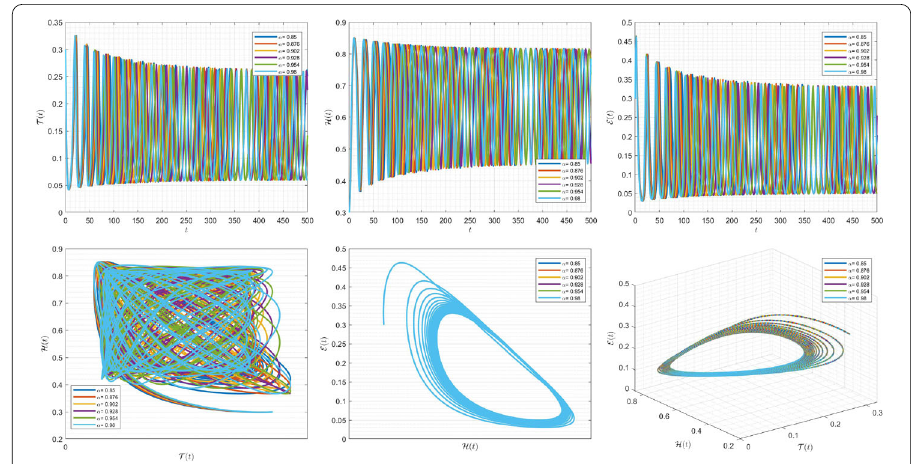
Figure 5 Simulations for solving (29) using (42) along with ( T (0), H (0), E (0)) = (0.3,0.3,0.3) and β 12 = 0.745